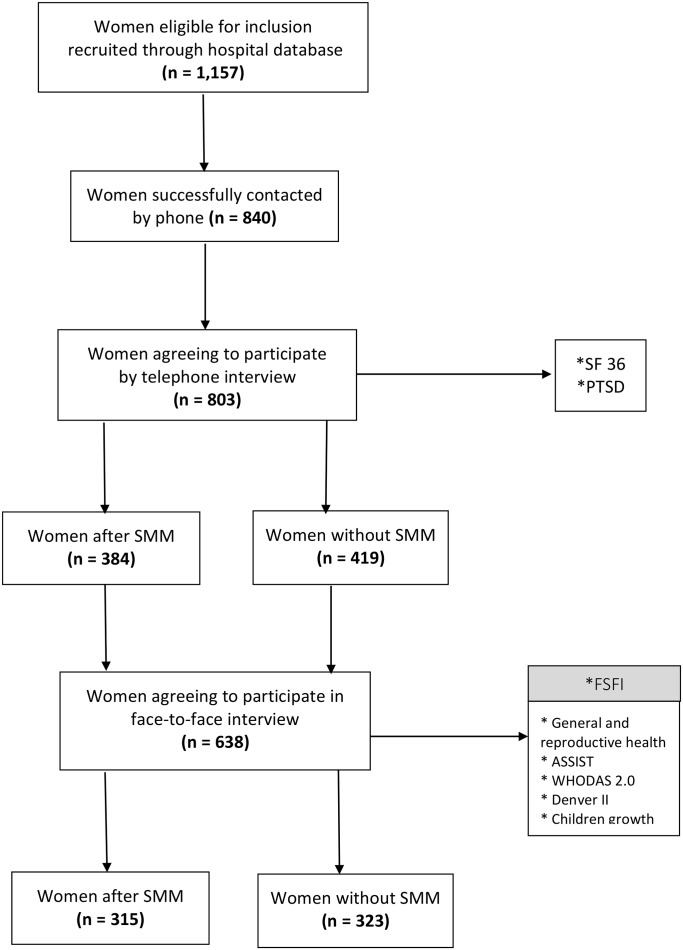
Flow chart for study inclusion.